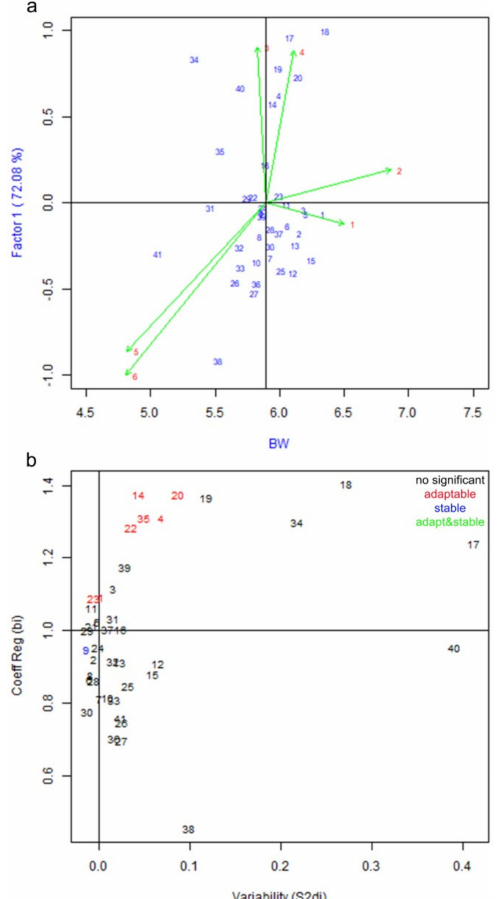
Figure 1. Mean performance and stability of 41 genotypes at six environments for boll weight (BW). ( a ) Represents the mean of BW (g per boll) on the X-axis and the first interaction principal component (IPC1) scores of GEI on the Y-axis. Blue and red colored numbers inside the biplot show genotypes and environments, respectively. ( b ) Shows the stability analysis of BW, coe ffi cient of variability (X-axis) and coe ffi cient of regression (Y-axis). All numbers inside the biplot show genotypes. See Tables 1 and 2 for code description of genotypes and environments,